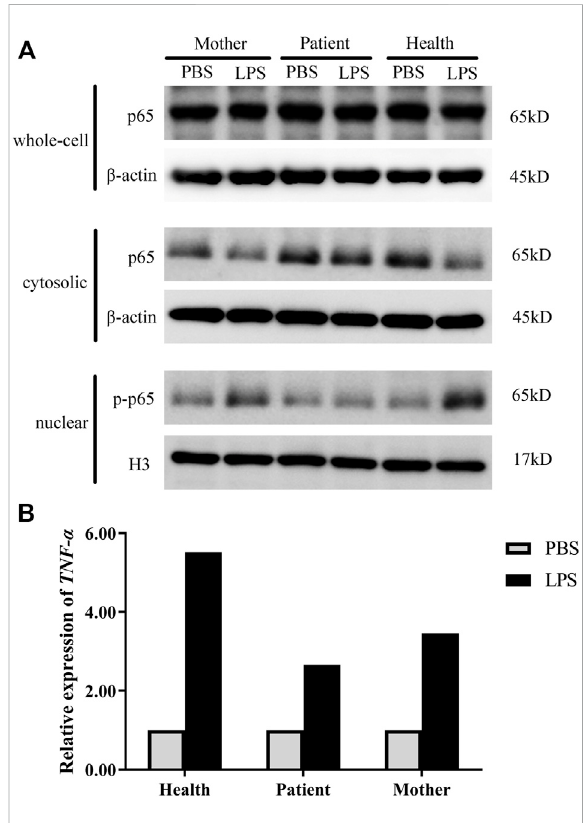
FIGURE 3 NF- κ B activation in the patient. (A) The protein levels of p65/ p-p65 in whole-cell lysates, cytosolic fractions, and nuclear extracts were measured by western blot analysis. (B) mRNA accumulation oftheTNF- α geneincellsderivedfromhealthy controls and the patient after LPS stimulation. PBS, unstimulated treatment; LPS, stimulated with LPS. Normalized target gene mRNA accumulation is reported relative to the mRNA accumulation in the PBS treatment of the healthy controls, which was set to 1.